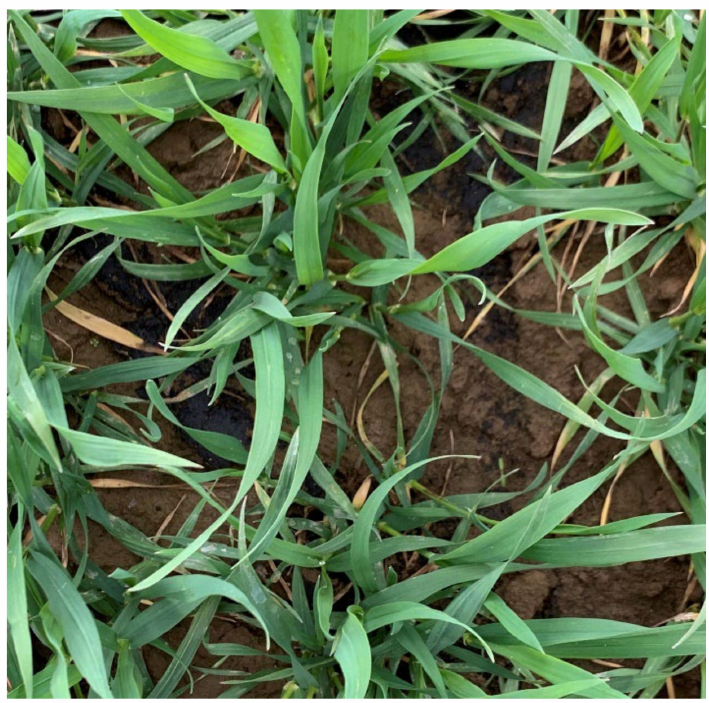
Figure 2. Example picture of a field with Winter Wheat, RGB, Detection